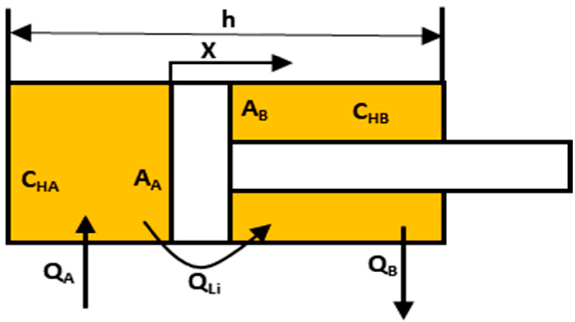
Figure 8. Schematic diagram of cylinder parameters.